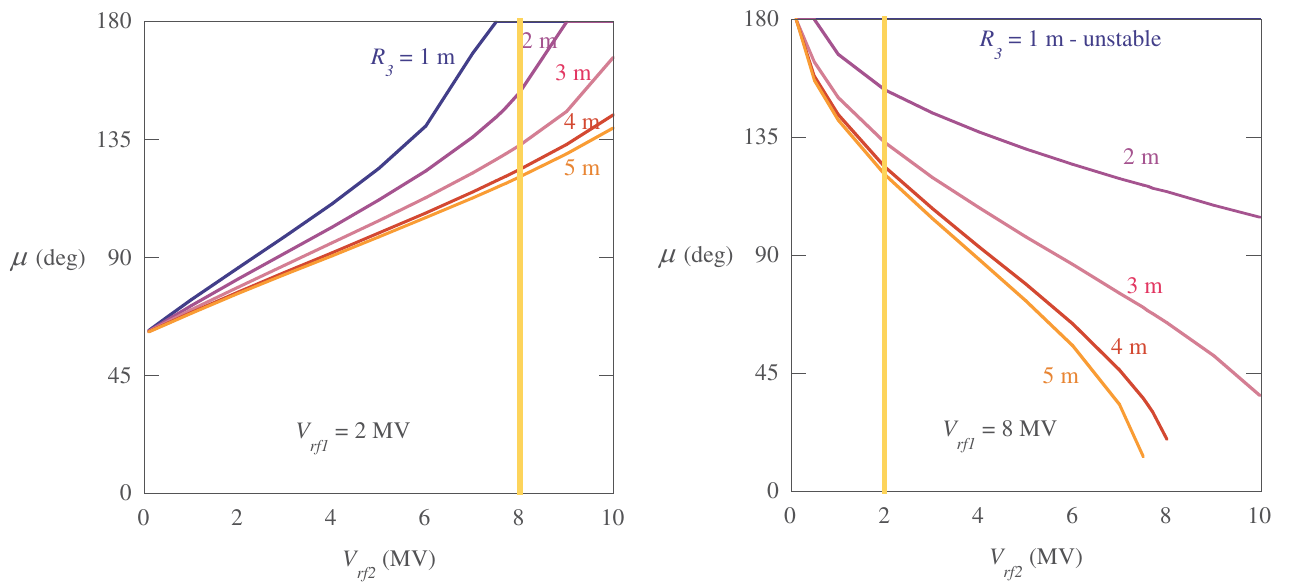
FIG. 13. (Color) Longitudinal phase advance as a function of the second rf cavity voltage in the case of the first weak rf cavity (cid:6) 2 MV ), or strong ( V (cid:6) 8 MV ). The different curves correspond to different value of R ( V rf1 rf1